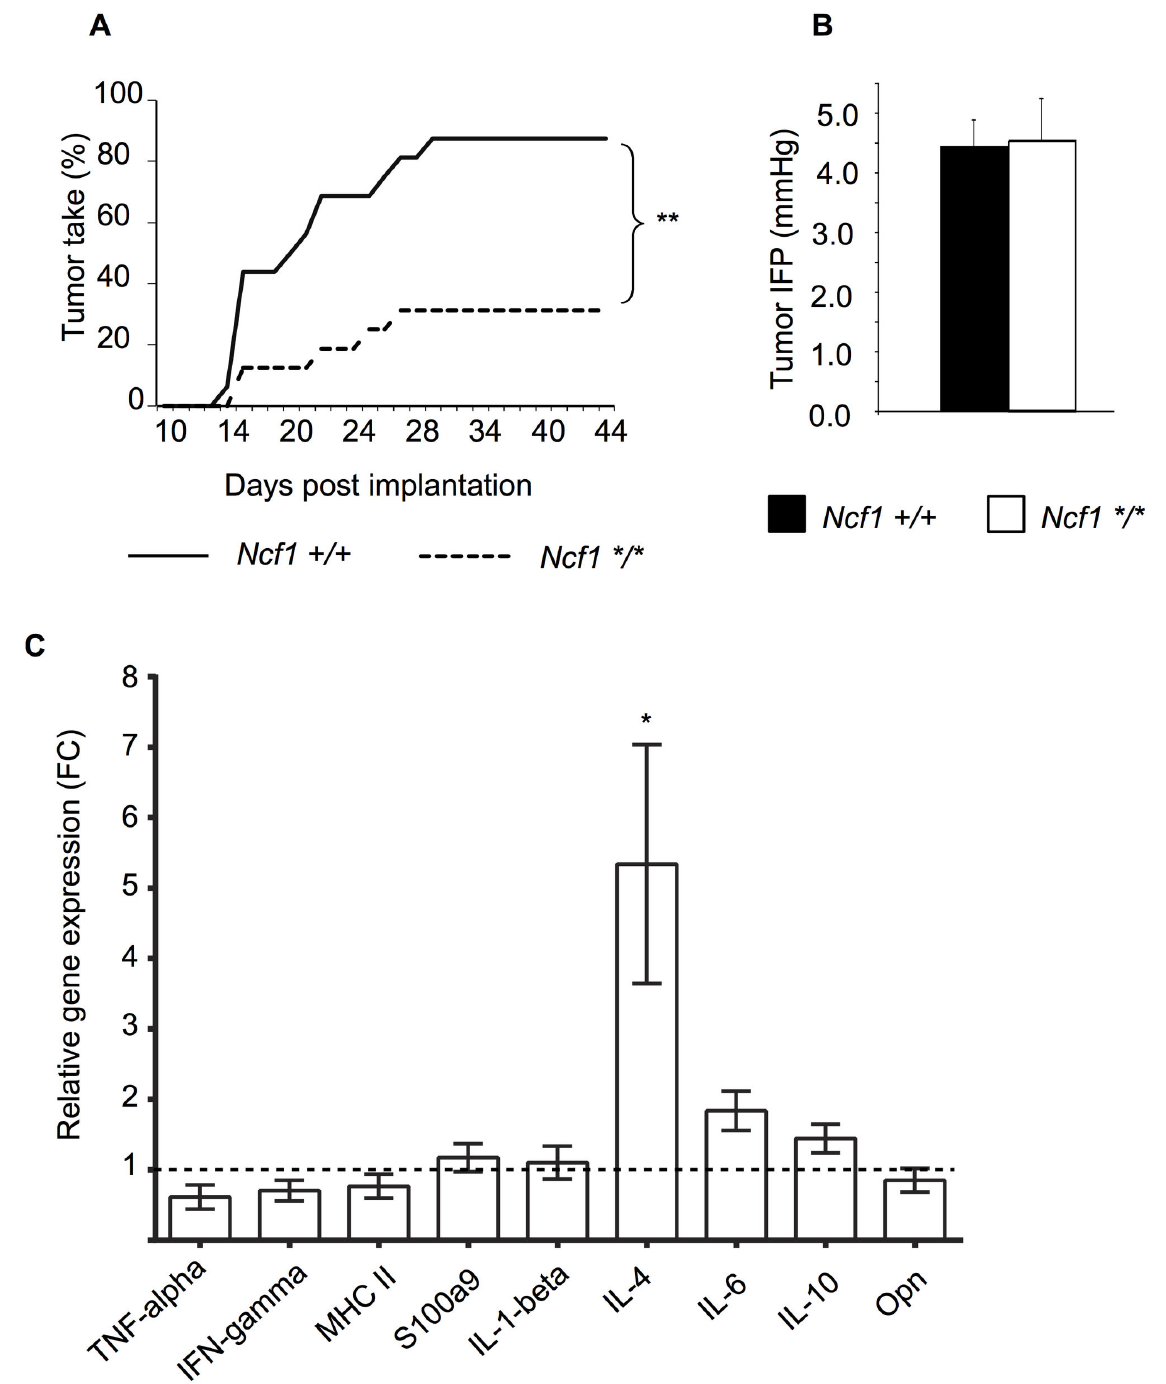
Figure 4. The development of LLC tumors is restricted in the absence of functional NOX2 complex. A ) The incidence of Lewis lung carcinoma (LLC) tumors in Ncf1 m1J mutated ( Ncf1*/* , n=16) and wild type ( Ncf1+/+ , n=16) mice, Chi square test. B ) Interstitial fluid pressure (IFP) was measured in the Ncf1 m1J mutated ( Ncf1*/* , n=9) and wild type ( Ncf1+/+ , n=9) mice, Student’s t- test. C ) LLC carcinoma tumors (n=5) were collected from Ncf1 m1J mutated and wild type mice and the tumors were subjected to qRT-PCR analysis of inflammatory cytokines. The average gene expression level in the tumors collected from the wild type mice was set to 1 and the results are presented as fold change (FC) relative to the wild type. Bars represent mean values ±SEM, Student’s t-test, p<0.05 is denoted with *. doi: 10.1371/journal.pone.0084148.g004 PLOS ONE |